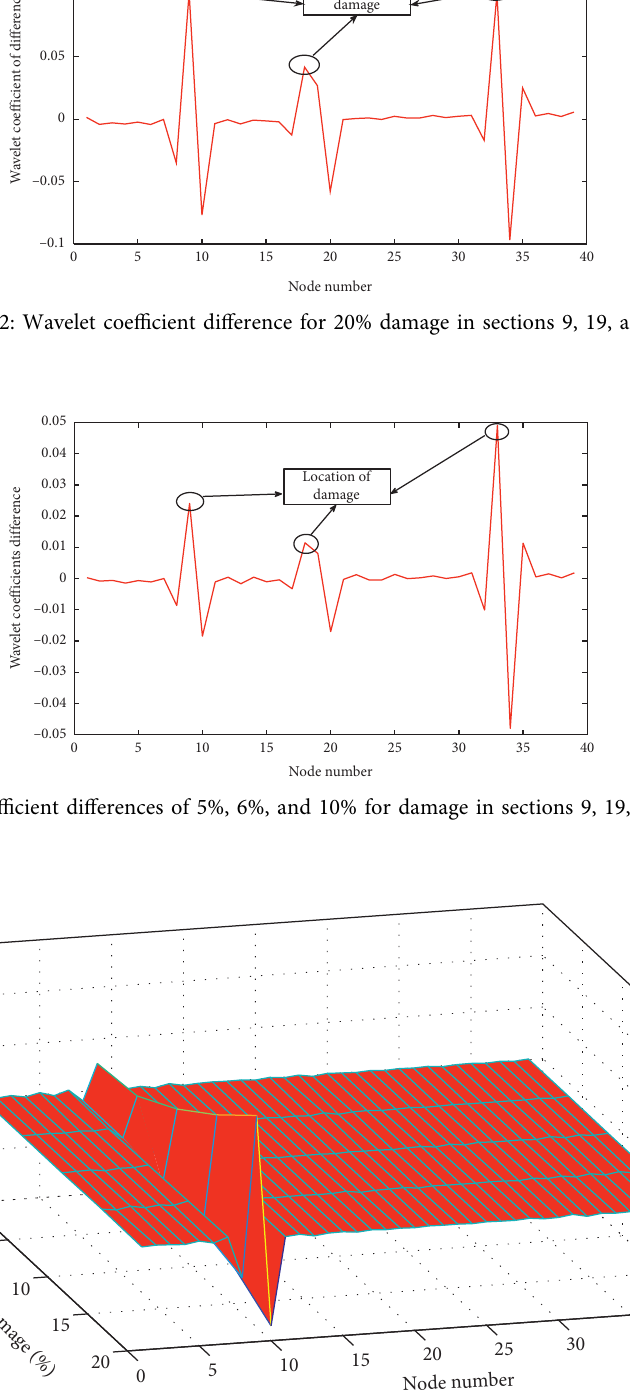
Figure 14: Three-dimensional curved surface of the single-damage wavelet coefficient in working condition